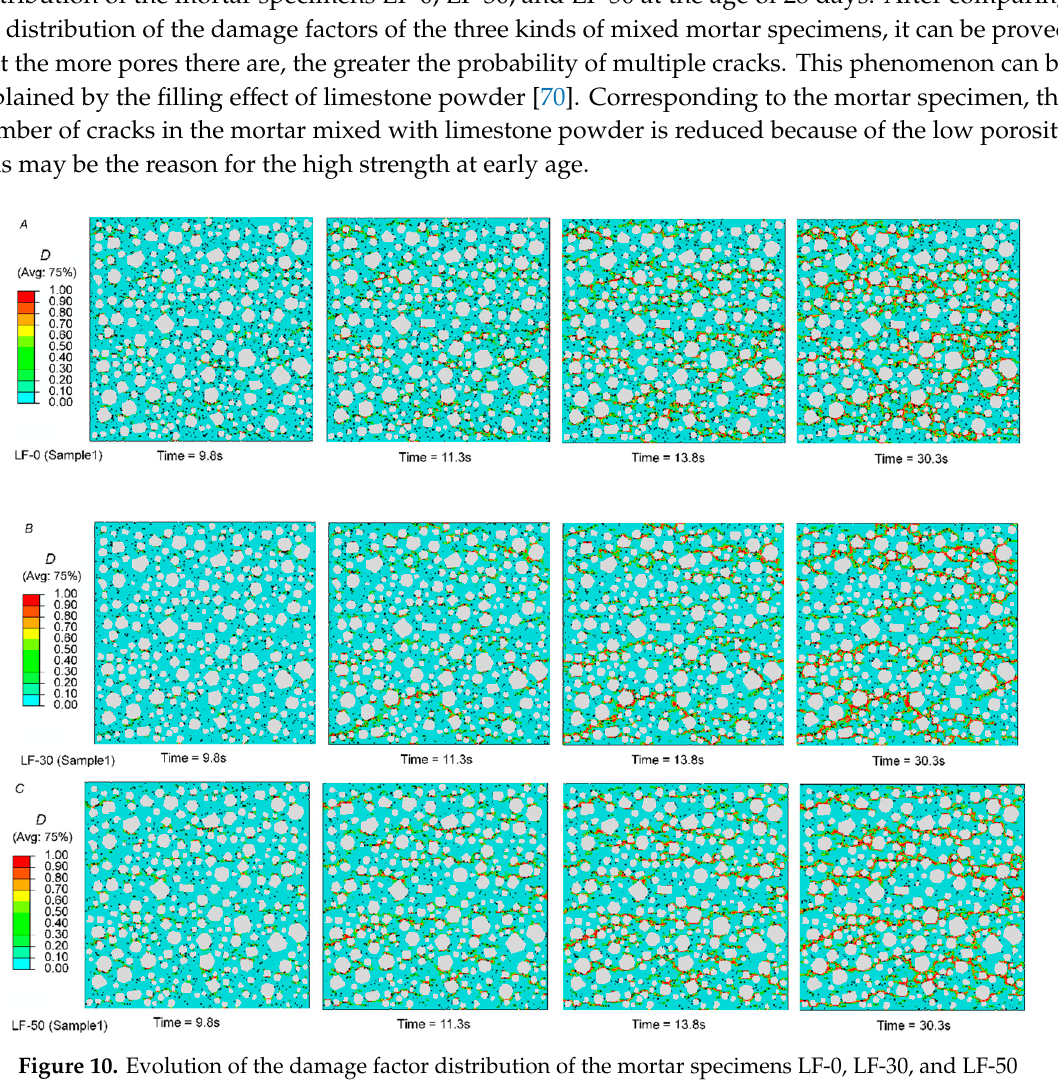
Figure 9. Strength–strain curves of the mortar specimens LF-30 at 7/28/90/180/365 days of age, and the comparison of the compressive strength between tested in physical experiments and the numerical simulation. ( A ) simulation of strength–strain curves at different days of age; ( B ) simulation of compressive strength at different days of age.